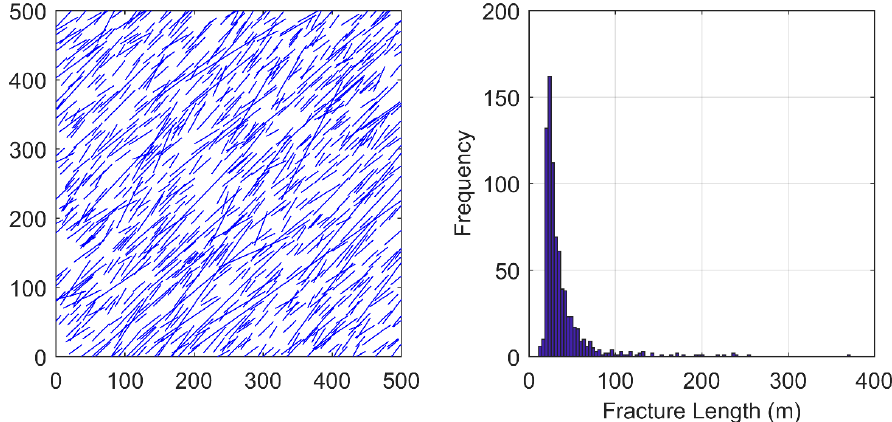
Figure 11. DFN for Case 2 ( left ) and its histogram of the fracture length distribution ( right ).